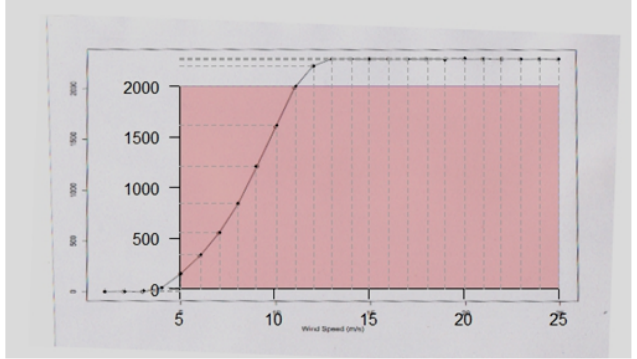
Figure A3. Extraction of discrete points from the WT power